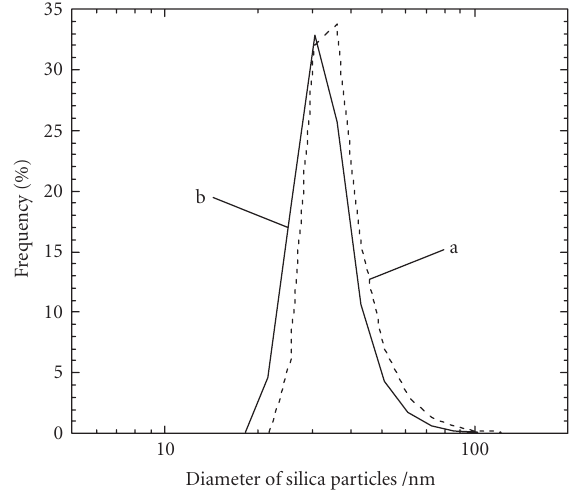
Figure 2: Size distribution of silica particles incorporating ZnSe- based NCs measured by dynamic light scattering method: (a) silica particles prepared using Solution 1 and (b) silica particles prepared using Solution 2.